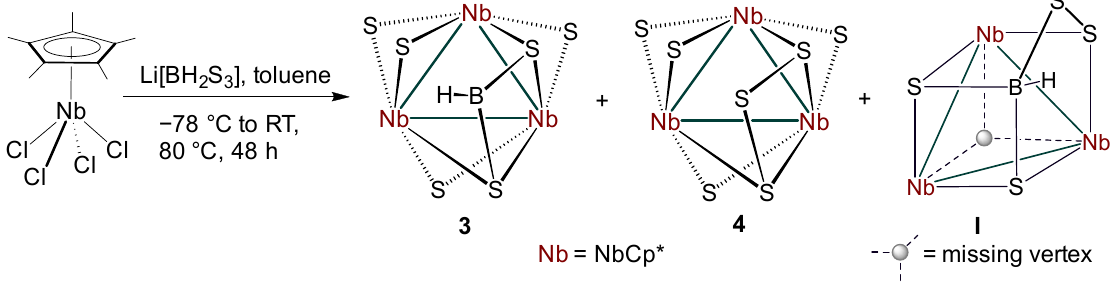
Scheme 2. Synthesis of the chalcogen-rich niobaborane ( 3 ) and trimetallic polychalcogenide ( 4 ) spe- cies (the μ -S in cluster I is omitted for clarity).